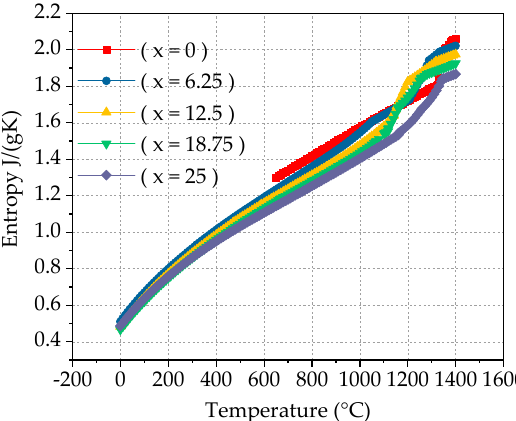
Figure 9. Entropy of mixing Δ S mix calculation for Fe 25 Cr 25 Ni 25 Ti x Al (25 − x) multi-principal element alloys.